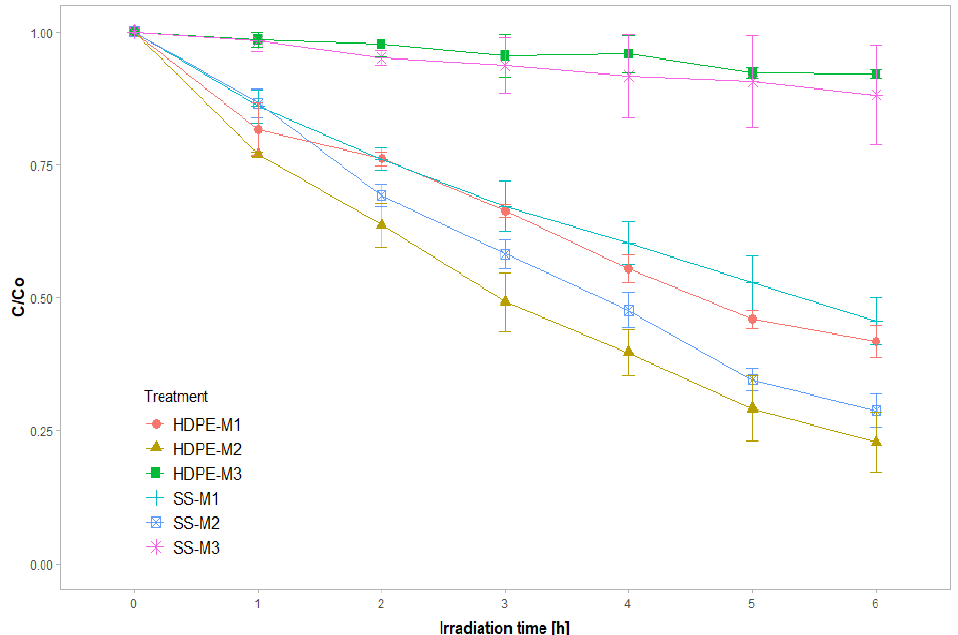
Figure 5. Degradation of the MB solution by P25 TiO 2 -coated materials for immobilization methods 1 (HDPE-M1, SS- M1), 2 (HDPE-M2, SS- M2) and 3 (HDPE-M3, SS- M3) under UV-A LED radiation (n = 3).